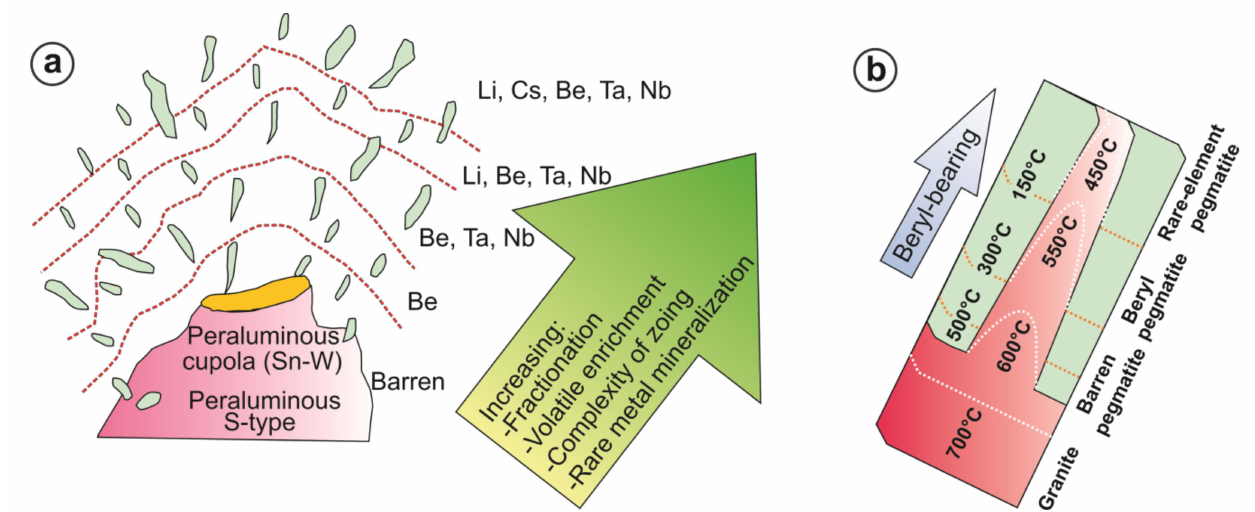
Figure 12. Schematic overview of regional zoning in a cogenetic parent + pegmatite group pegmatite increasing in the degree of evolution with increasing distance from the parent granite. Incompatible elements are more enriched in the most distal pegmatite [12,55]. ( a ) By increasing the distance from peraluminous S-type magma, the fractionation degree increased, the volatile value could be enriched, the zoning became more complex, and rare metals precipitated in the distal part. ( b ) During the undercooling of the pegmatite dike, in the proximal part, barren pegmatite formed with the mineral sequence of plagioclase (An 10-15 ), muscovite, and K-feldspar, beryl was saturated at approximately 600 ◦ C, and Be-pegmatite was produced. In the distal pegmatite, rare metal mineralization occurred. Modified from Selway et al.